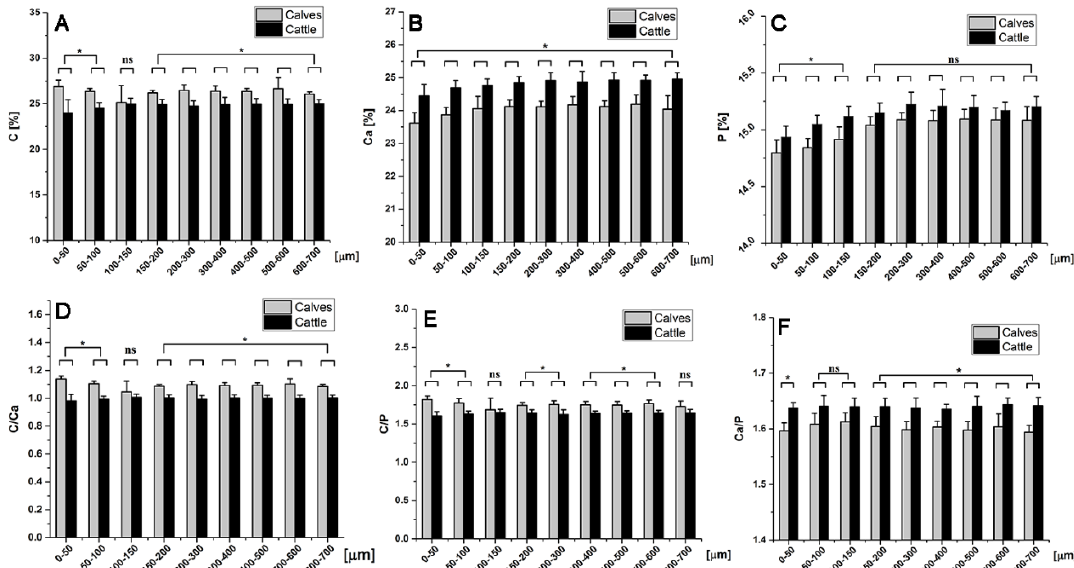
Figure 4. Chemical composition of the SCZ was analyzed via energy-dispersive X-ray spectroscopy (EDX) at different depths. Starting from the tidemark towards the deeper SCBP, carbon, calcium, and phosphorous